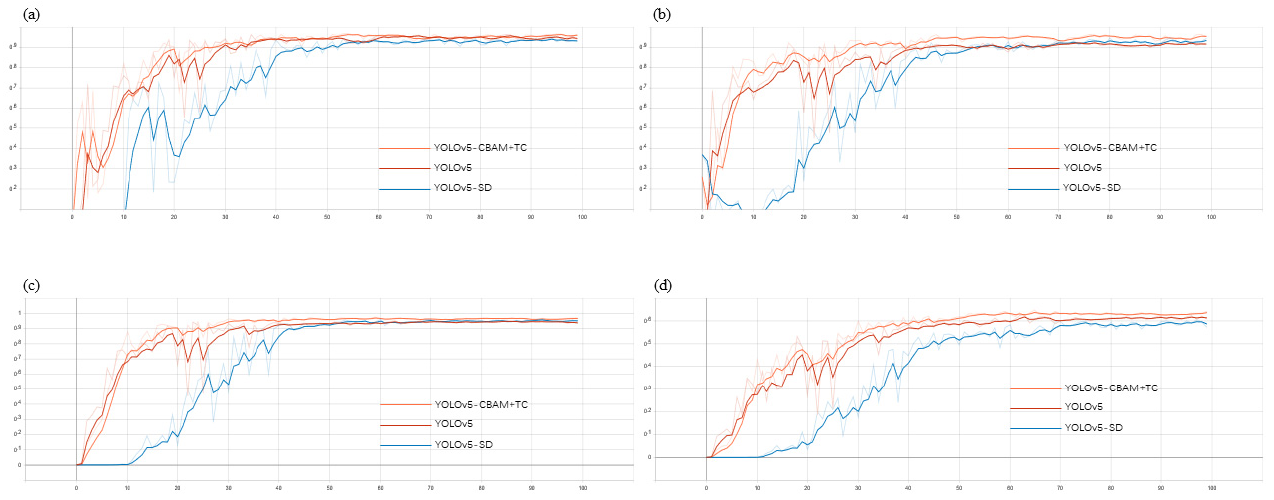
Figure 6. Experimental results of the three models: ( a ) precision; ( b ) recall; ( c ) mAP@0.5; ( d ) mAP@0.5:0.95.